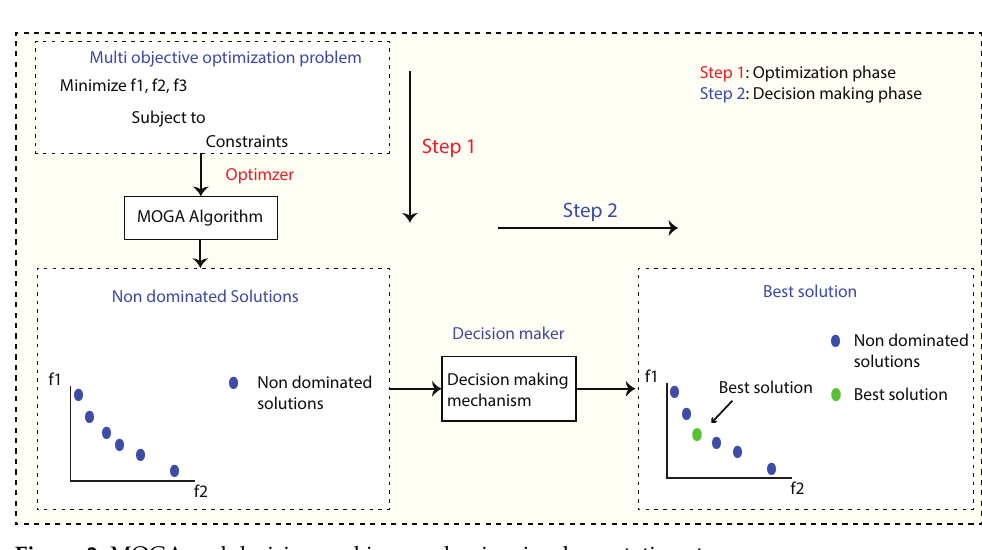
Figure 2. MOGA and decision-making mechanism implementation steps.